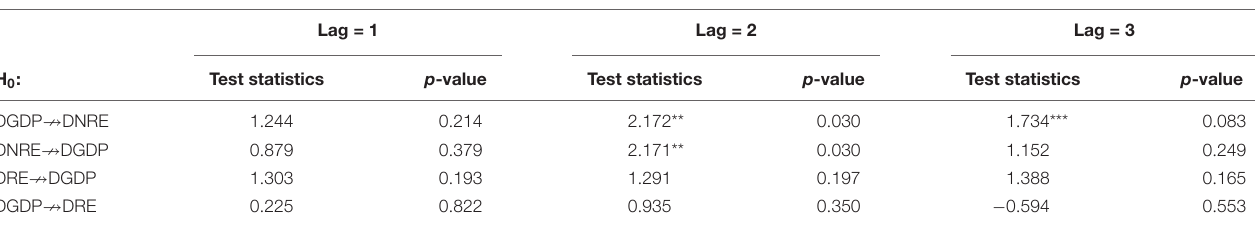
TABLE A2 | Results of dumitrescu- hurlin panel causality